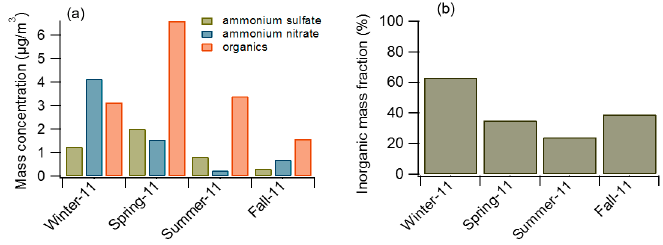
Figure 4. Seasonal average of ( a ) organic and inorganic mass concentration and ( b ) the inorganic mass fraction (%) in 2011.